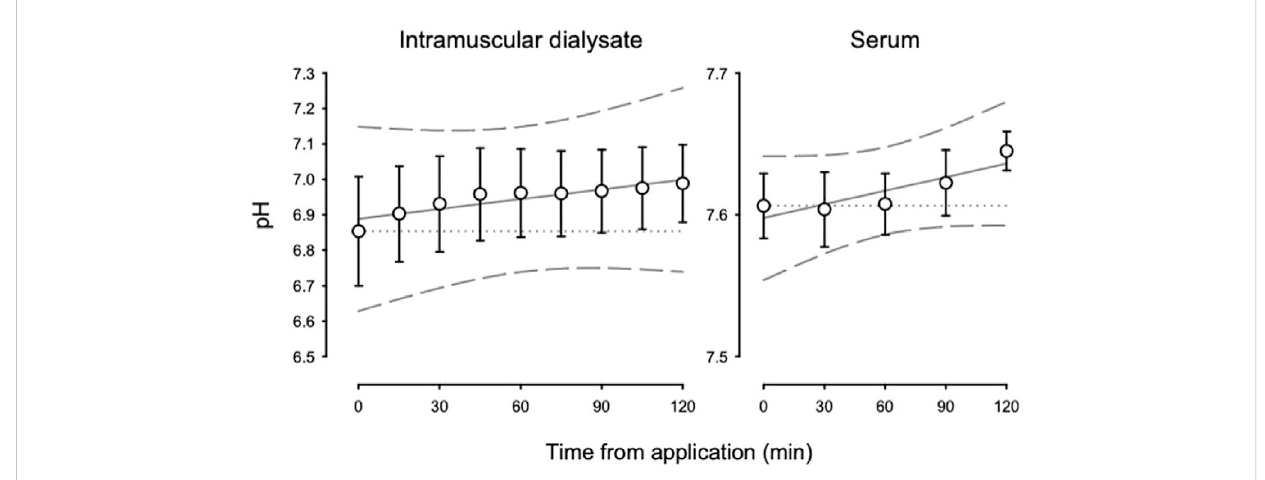
FIGURE 2 Intramuscular dialysate pH (left panel) and serum pH (right panel) during the primary study from baseline to end-of-study.